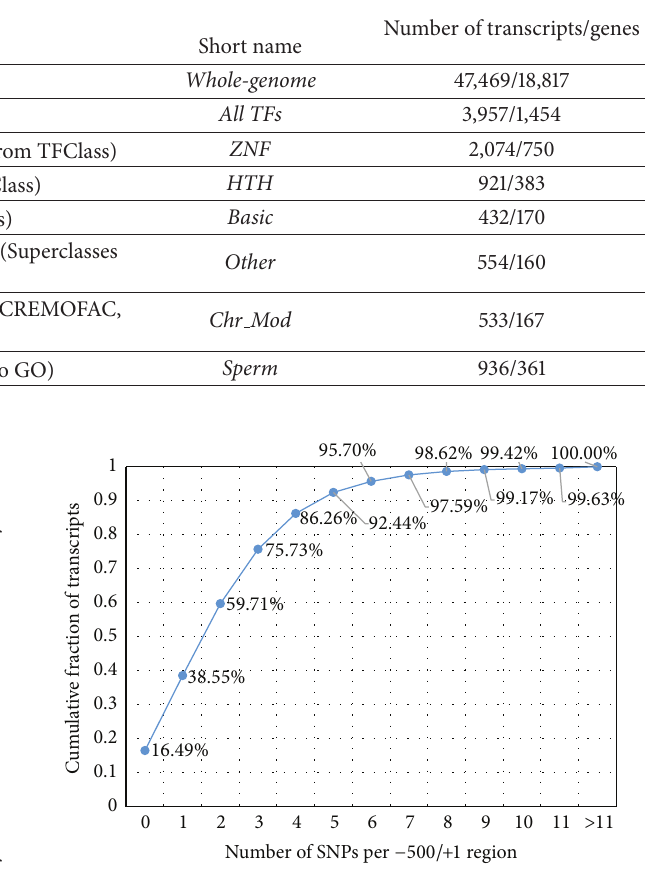
Figure 1: Cumulative percentage plot for the fraction of human transcripts from the whole-genome dataset, possessing certain numbers of SNPs in their 500 bp long regions upstream annotated transcription start sites. 𝑥 -axis denotes the threshold SNP content in 500 bp upstream TSS. 𝑦 -axis denotes the cumulative fraction of the whole-genome dataset of